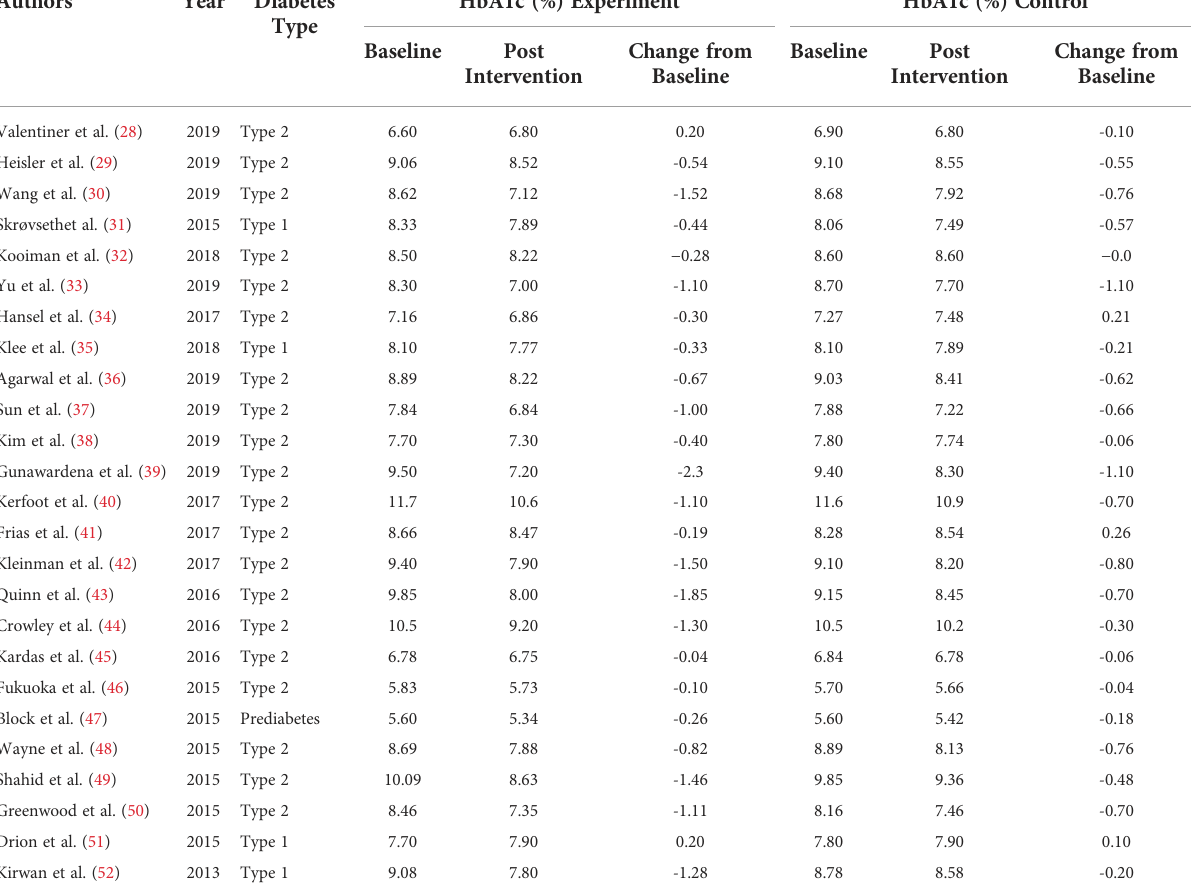
TABLE 4 Trial results according to HbA1c (%)